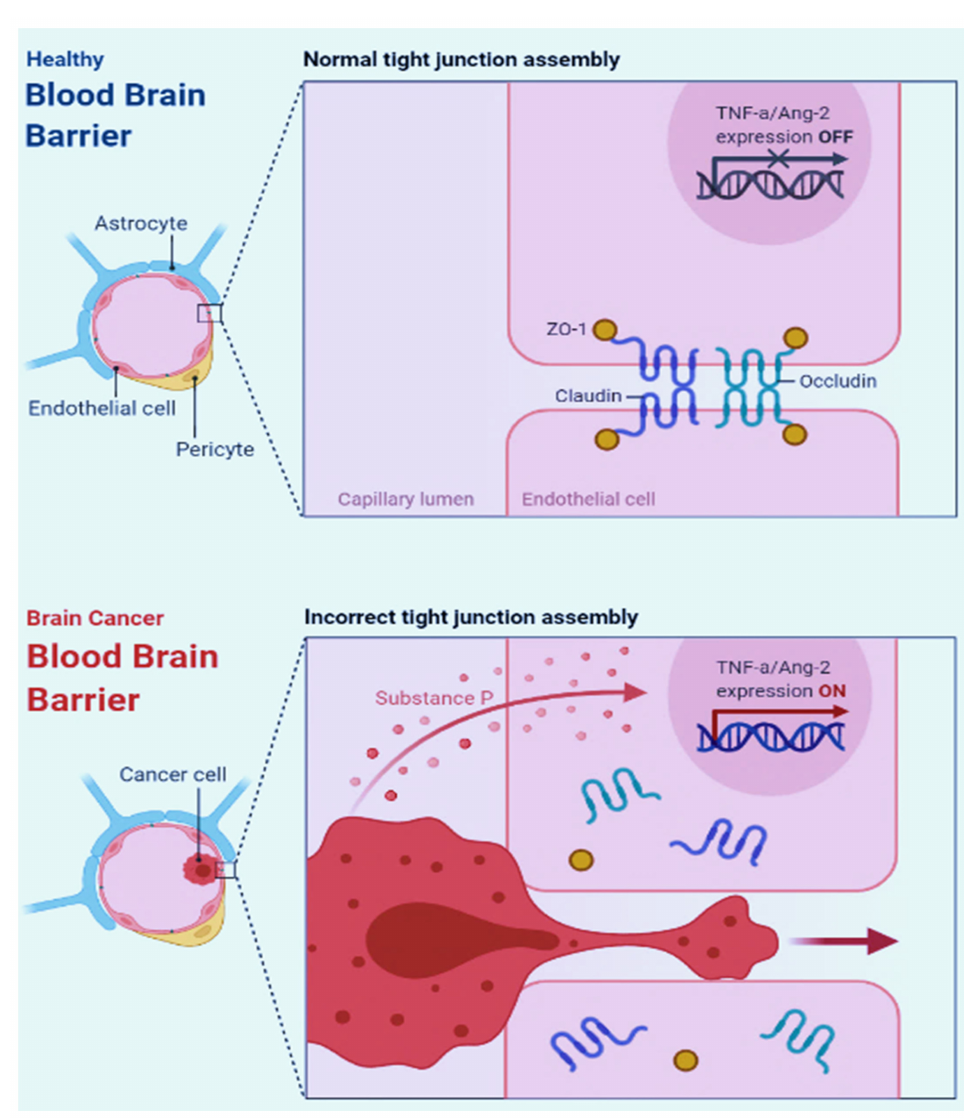
Figure 2. The difference between healthy BBB (BBB) and BT